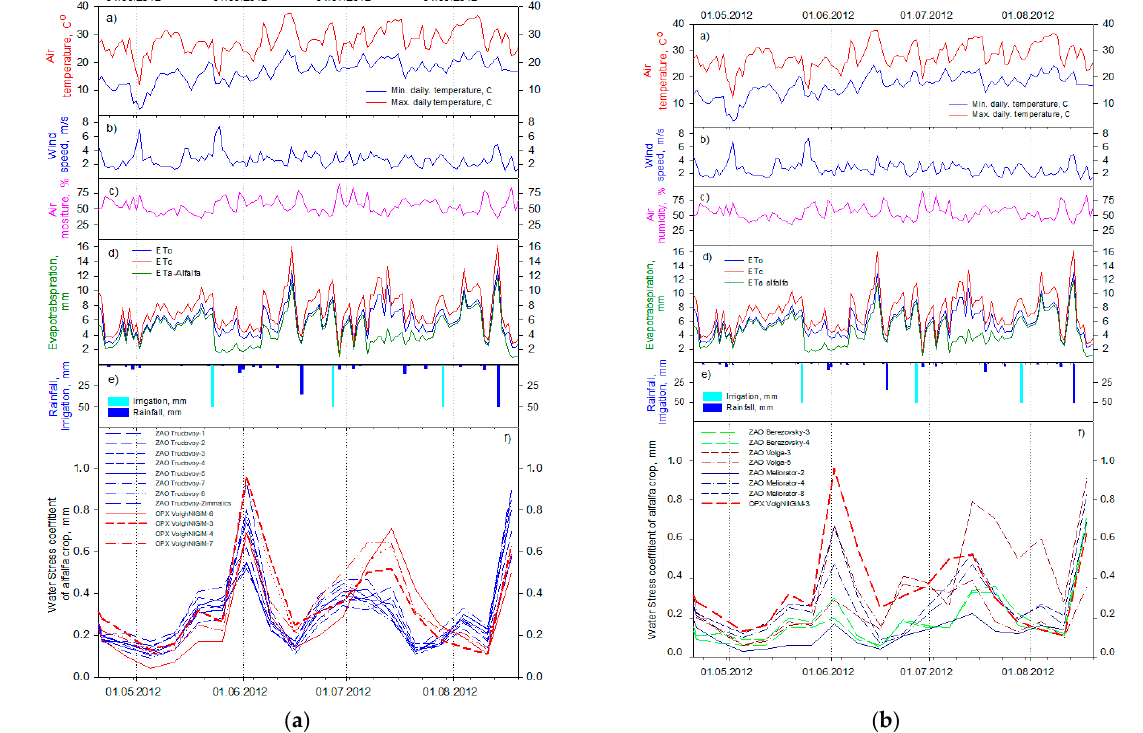
Figure 2. Agrohydrological characteristics of the monitored alfalfa crops over the irrigation period of 2012: ( a ) ZAO “Trudivoi” and OPX VolzhNiigiM; ( b ) ZAO”.